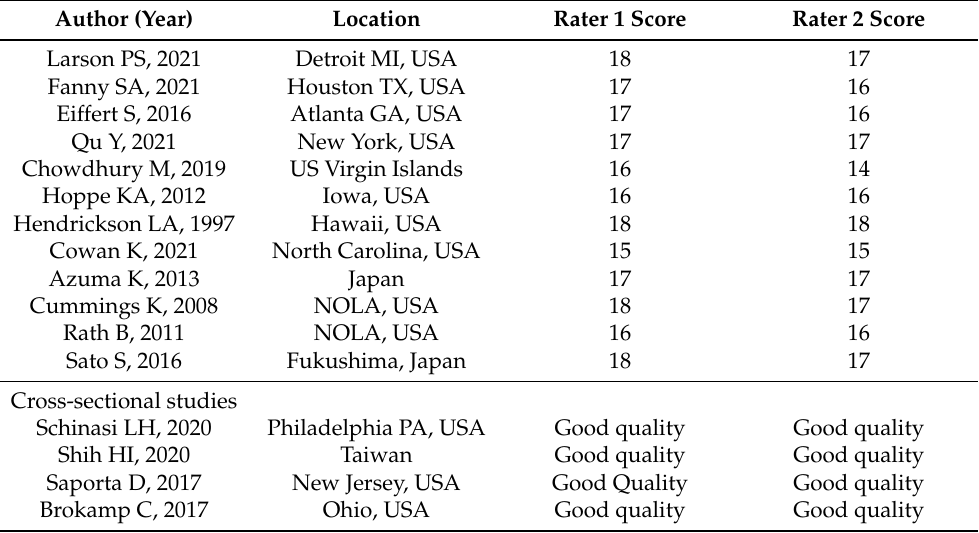
Table 4. Cross Sectional Study AXIS